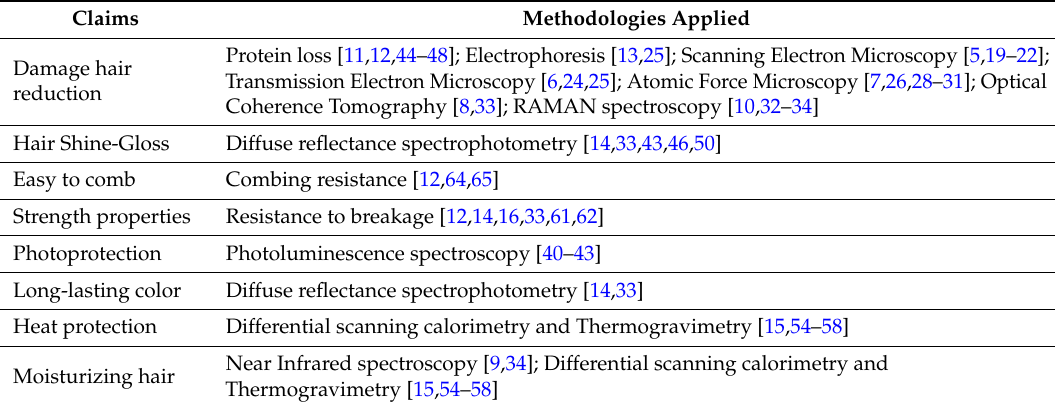
Table 1. A summary table of the methodologies applied to test each claim of hair care